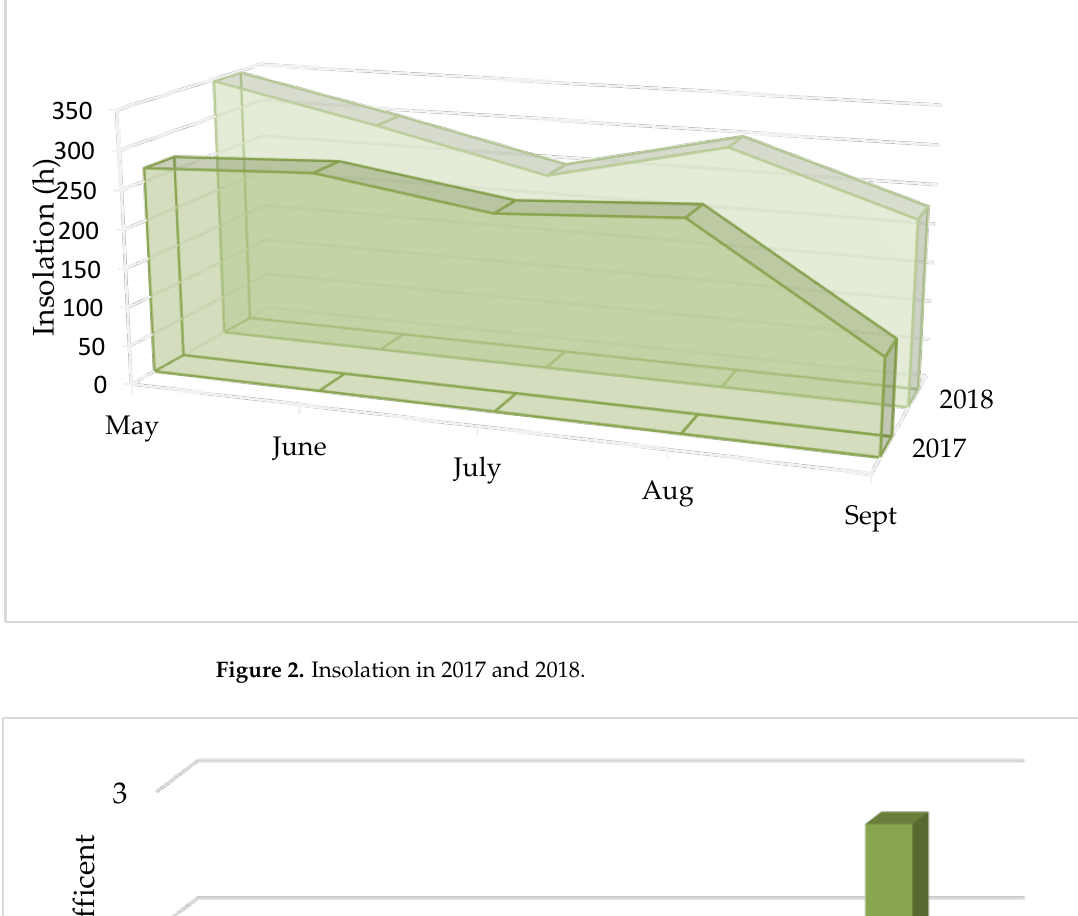
Figure 2. Insolation in 2017 and 2018.